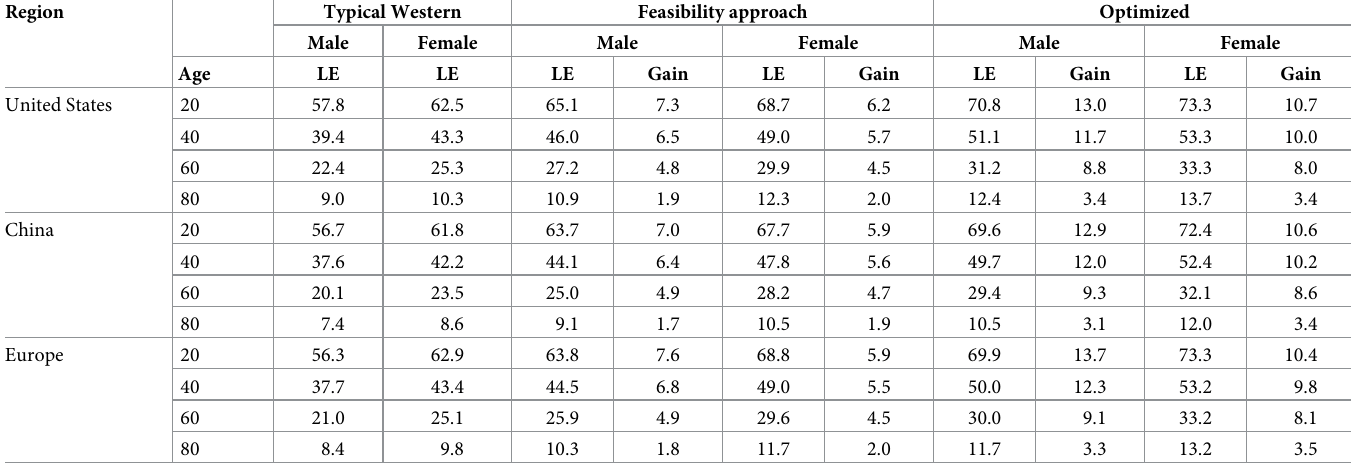
Table 1. LE for males and females at different ages from the United States, China, and Europe for different diets. Gain in LE when changing from a typical Western diet to a feasibility approach or optimized diet is also indicated. Region Typical Western Feasibility approach Optimized Male Female Male Female Male Female